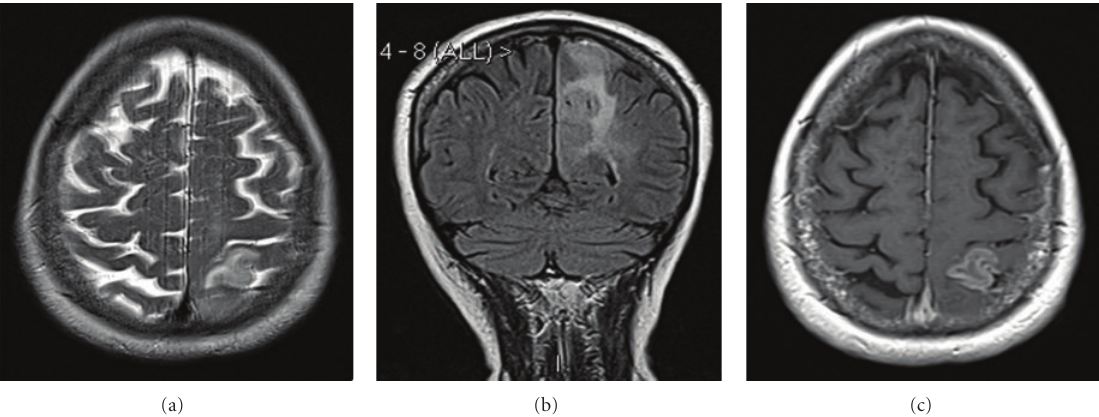
Figure 4: Axial T2 (a), coronal FLAIR (b), and axial T1 post-Gadolinium image (c) from 6-months followup MR scan, showing significant progression of the lesion and a new area of enhancement in the left parietal